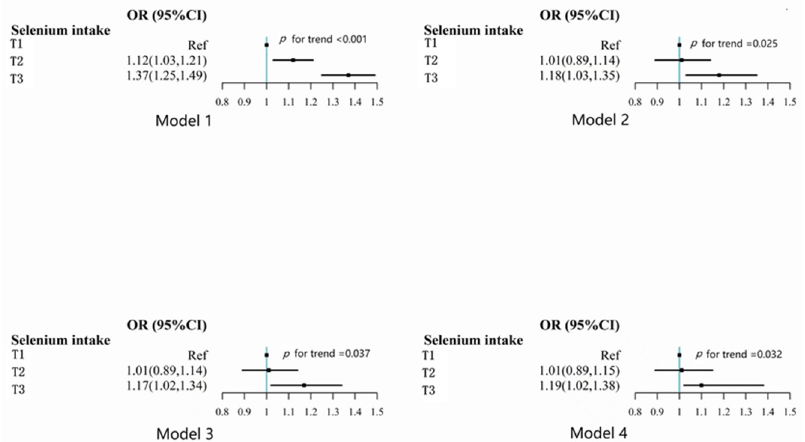
Figure 1. Flow chart of participants in the Selenium Intake and Sleep Survey.